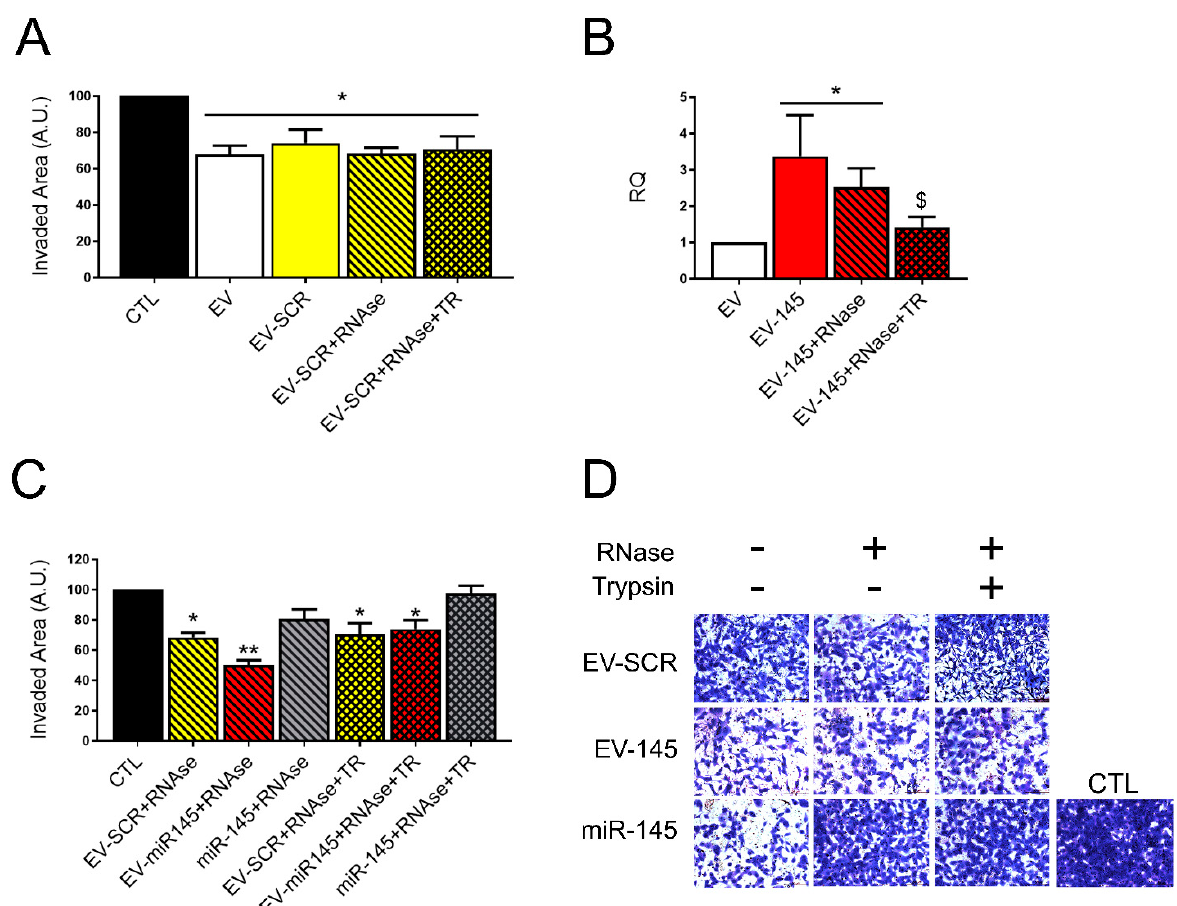
Figure 3. Anti-tumor effect of miR145 coincubated HLSC-EVs after RNase but not trypsin treatment. ( A ) Invasion assay quantification of rCSCs treated for 48 h with naïve HLSC-EVs (EV), or with HLSC-EVs coincubated with a scrambled sequence (EV-SCR), EV-SCR digested with RNase-A (EV-SCR + RNase) and EV-SCR treated with RNase. Data are represented as mean of the percentage of invaded area of one experiment performed in triplicate. ( B ) Real Time analysis showing miR-145 levels in naïve HLSC-EVs (EV), HLSC-EVs coincubated with miR-145 untreated (EV-145) or digested with 0.1 ng/µL RNase-A (EV-145 + RNAse), or digested with RNase and treated with trypsin (EV-145 + RNase + TR). Data are represented as mean ± SD of three independent experiments of the Relative Quantification (RQ) normalized to naïve EVs (EV) and to RNU6B. * = p < 0.05 vs. EV and $ = p < 0.05 vs. EV-145. ( C , D ) Invasion assay quantification ( D ) and representative micrographs ( E ) of rCSCs treated for 48 h with naïve HLSC-EVs (EV), or with HLSC-EVs coincubated with a scrambled sequence or with miR-145 and digested with RNase-A (EV-SCR + RNase and EV-miR145 + RNase, respectively), or with EV-SCR + RNase and EV-miR145 + RNase treated with trypsin (EV-SCR + RNase + TR and EV-miR145 + RNase + TR, respectively). Free miR-145, treated with RNase (miR145 + RNase) or with RNase and trypsin (miR145 + RNase + TR), was used as control. Data are represented as mean of the percentage of invaded area of two experiments performed in triplicate. An ANOVA analysis was performed: * = p < 0.05 and ** = p < 0.001 vs. untreated rCSCs